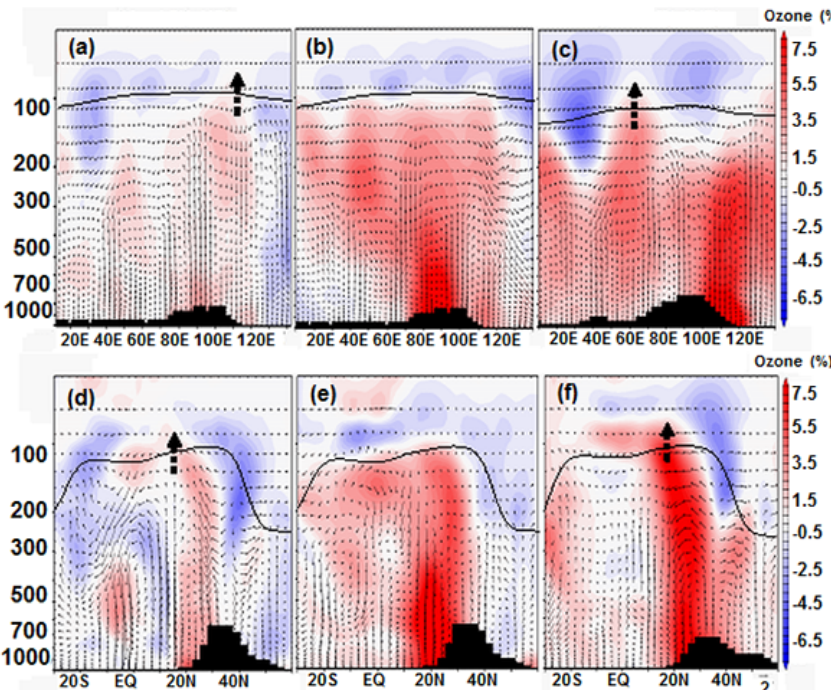
Figure 4. Longitude–pressure cross section of percentage ozone anomalies averaged for the monsoon season (June–September) obtained from (a) Ind38 (averaged over 8–35 ◦ N), (b) Ind73 (averaged over 8–35 ◦ N), and (c) Chin73 (averaged over 20–45 ◦ N) simulations. Latitude– pressure cross section of percentage ozone anomalies averaged for the monsoon season (June–September) obtained from (d) Ind38 (averaged over 70–90 ◦ E), (e) Ind73 (averaged over 70–90 ◦ E), and (f) Chin73 (averaged over 85–120 ◦ E) simulations. Black arrows indicate wind vectors. The vertical velocity field has been scaled by 300. The black line represents the tropopause, and the black dashed arrows indicate the cross-tropopause